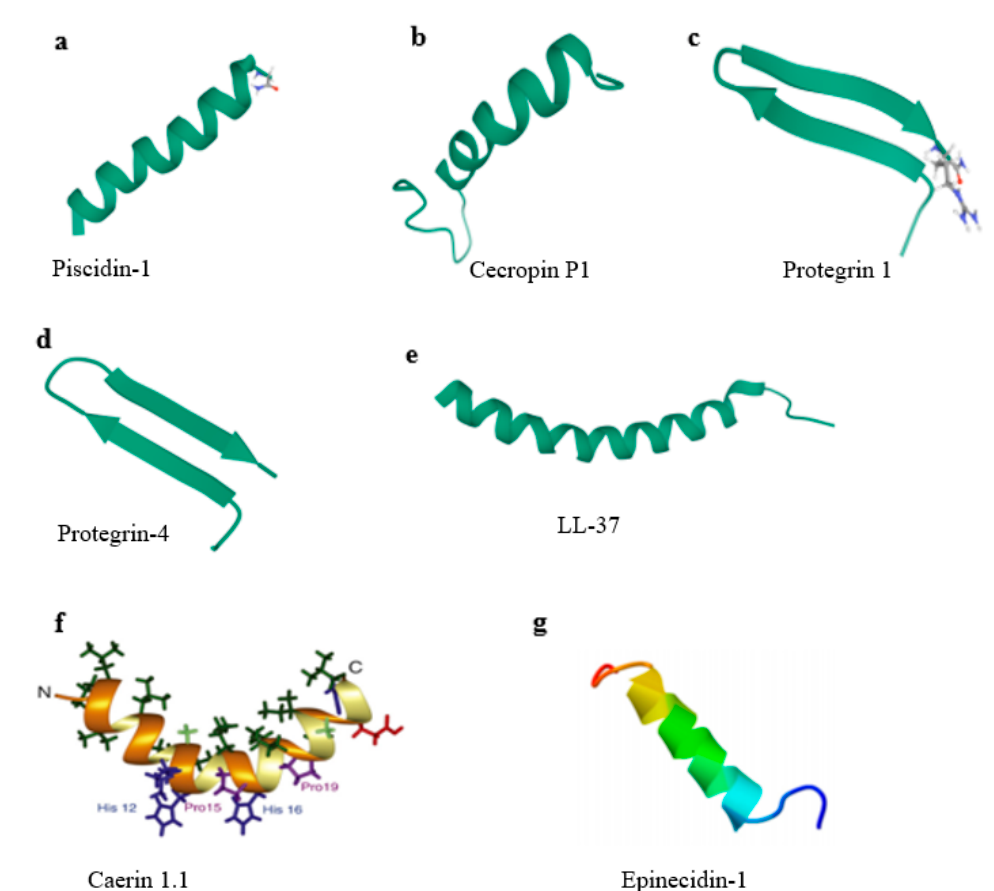
Figure 2. Structure types of typical AMPs. ( a ) Solid-state NMR structure of piscidin-1 in aligned 1:1 phosphatidylethanolamine / phosphoglycerol lipid bilayers (PDB ID 2MCV). ( b ) Solution structure of cecropin P1 with LPS (PDB ID 2N92). ( c ) Protegrin 1 from porcine leukocytes, NMR, 20 structures (PDB ID 1PG1). ( d ) Structure of protegrin-4 by high-resolution NMR spectroscopy (PDB ID 6QKF). ( e ) Structure of human LL-37 (PDB ID 2K6O). ( f ) Solution structures of caerin 1.1 [56]. ( g ) Structure of epinecidin-1 [57].